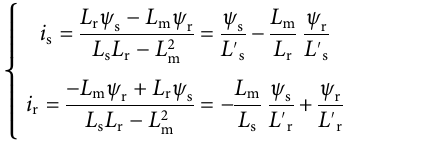
− t / τ / dt (cid:1) u s , which is the 0 e s